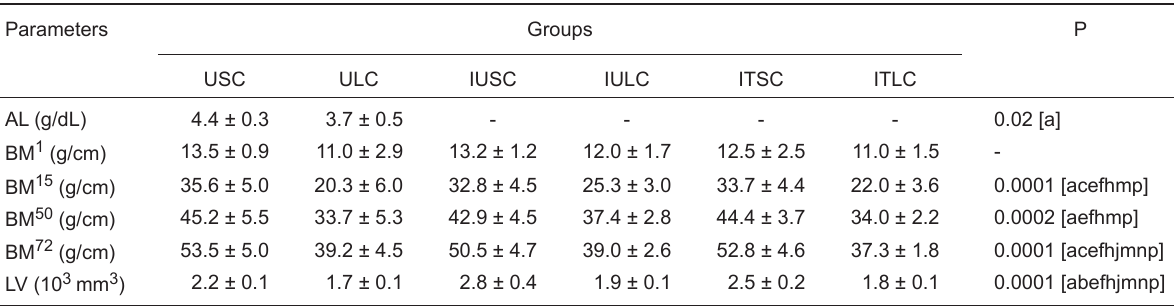
Table 1. Biochemical and biometrical characteristics of schistosomiasis-infected Swiss Webster mice fed low-protein or standard chow and treated or not with praziquantel.